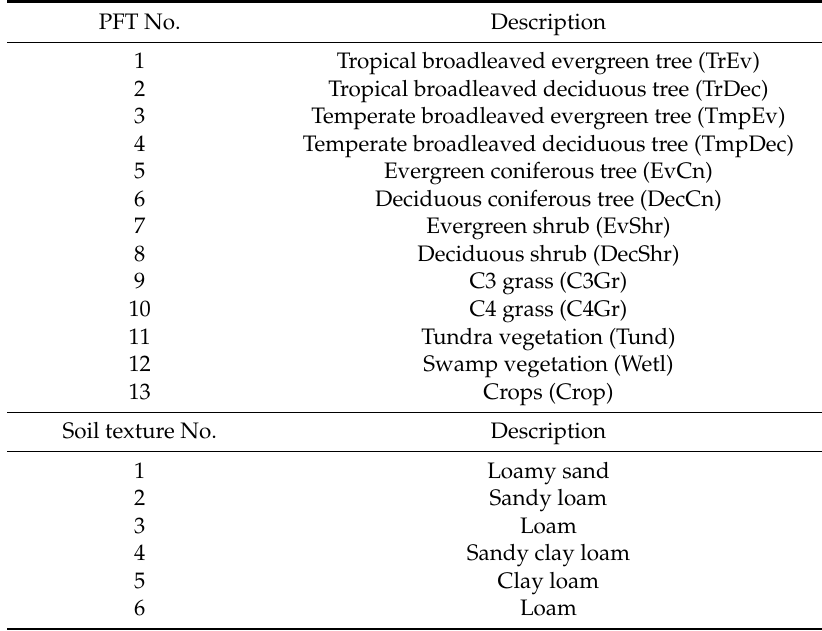
Table A1. PFT and soil texture descriptions in BETHY model.